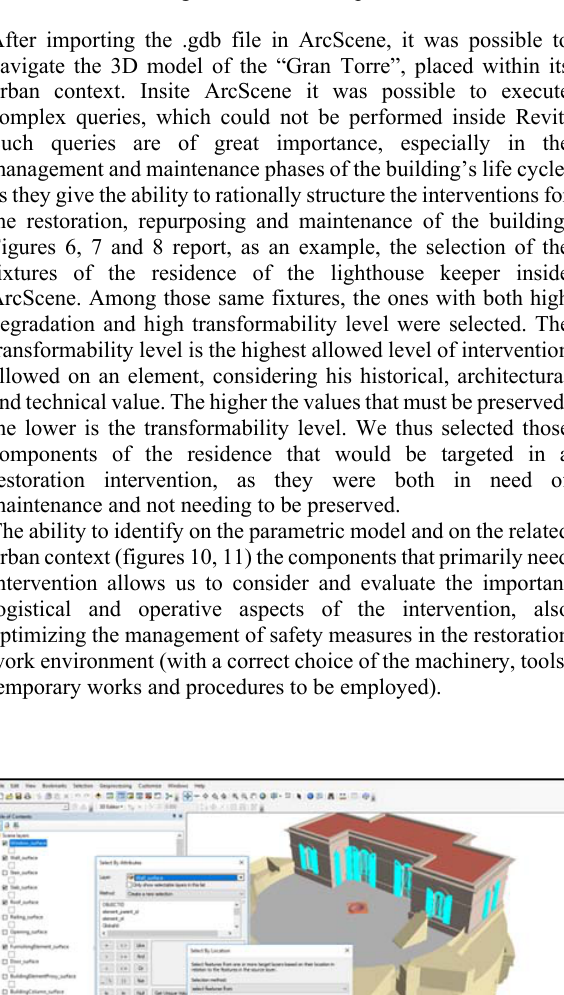
Figure 6. FME workspace